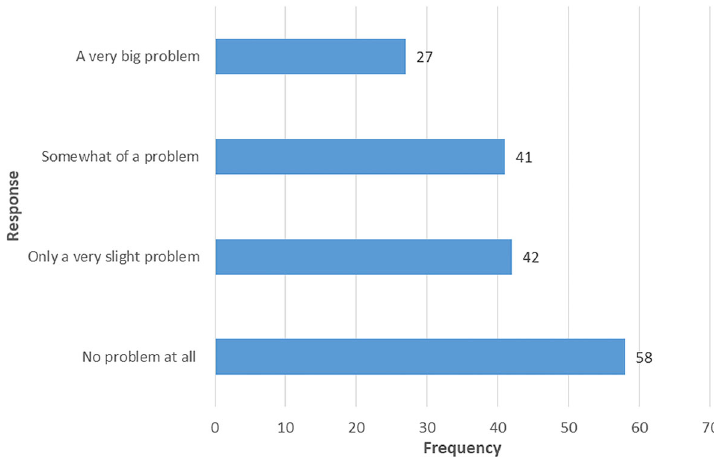
Figure 2. Response on “ During the past month, how much of a problem has it been for you to keep up enough enthusiasm to get things done? ”